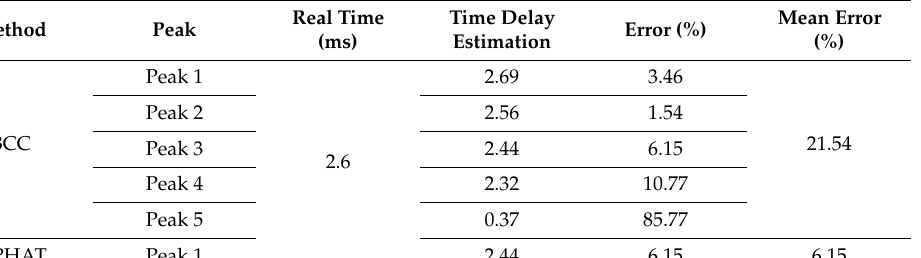
Table 1. Leak localization results.